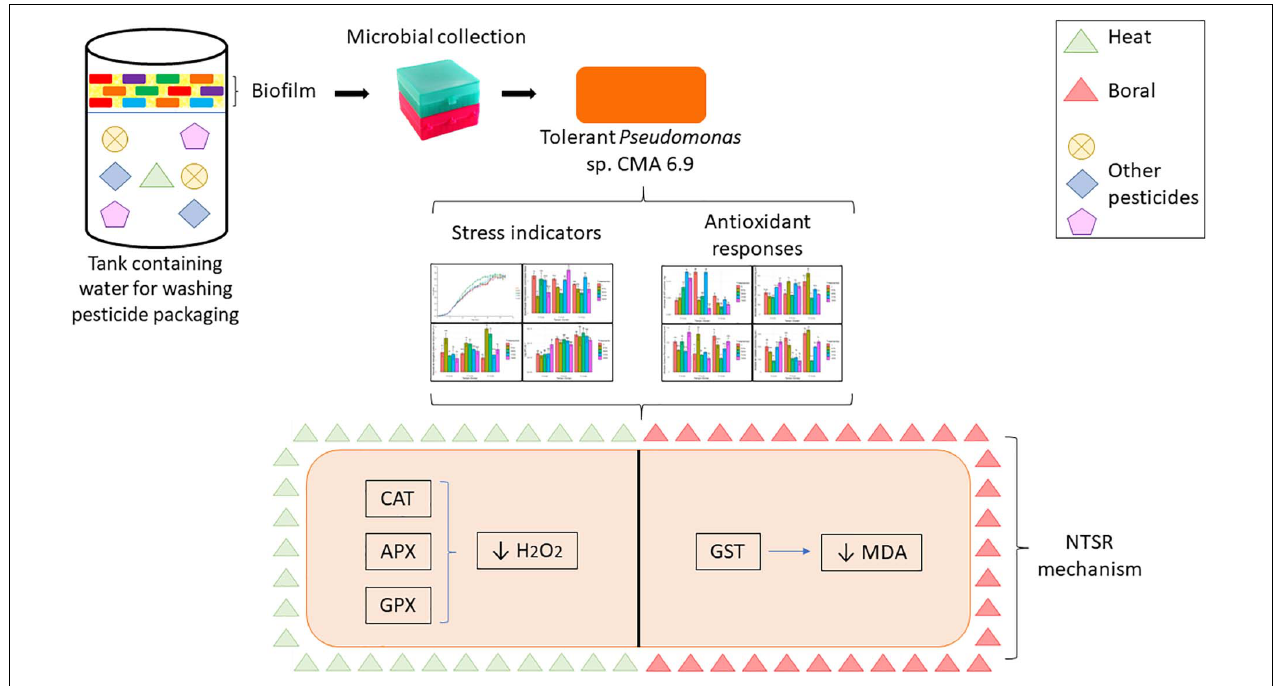
FIGURE 1 | Experimental design showing the tests performed for the preliminary characterization of the lineage and evaluations of oxidative stress indicators and stress response systems.